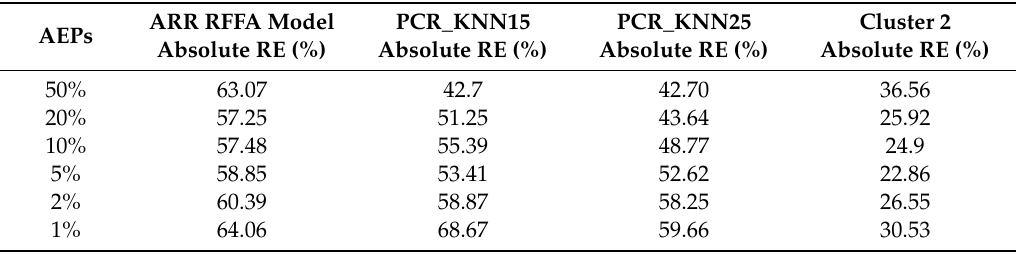
Table 13. Comparison of absolute RE (%) values between ARR RFFA model and PCR KNN15, PCR KNN25, and QRT models for cluster